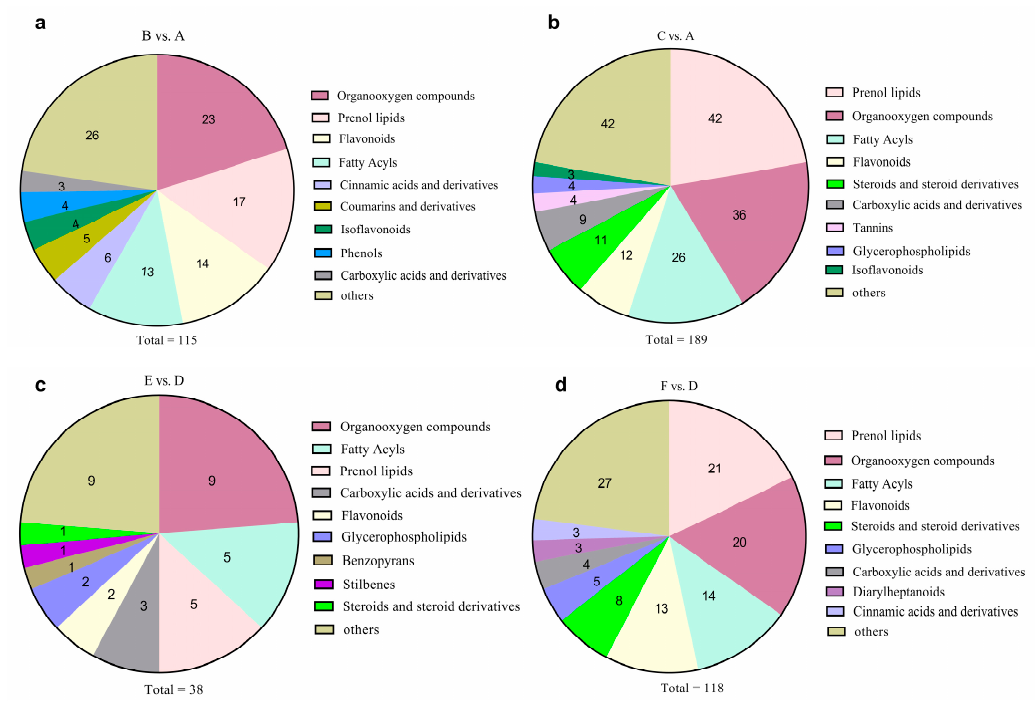
Figure 5. Classification of annotated SCMs using the HMDB database between different comparison groups, ( a ) B vs. A, ( b ) C vs. A, ( c ) E vs. D, ( d ) F vs. D. A, C. weiningensis treated with 20 °C; B, C. weiningensis treated with 4 °C; C, C. weiningensis treated with − 4 °C; D, C. oleifera treated with 20 °C; E, C. oleifera treated with 4 °C; F, C. oleifera treated with − 4 °C.